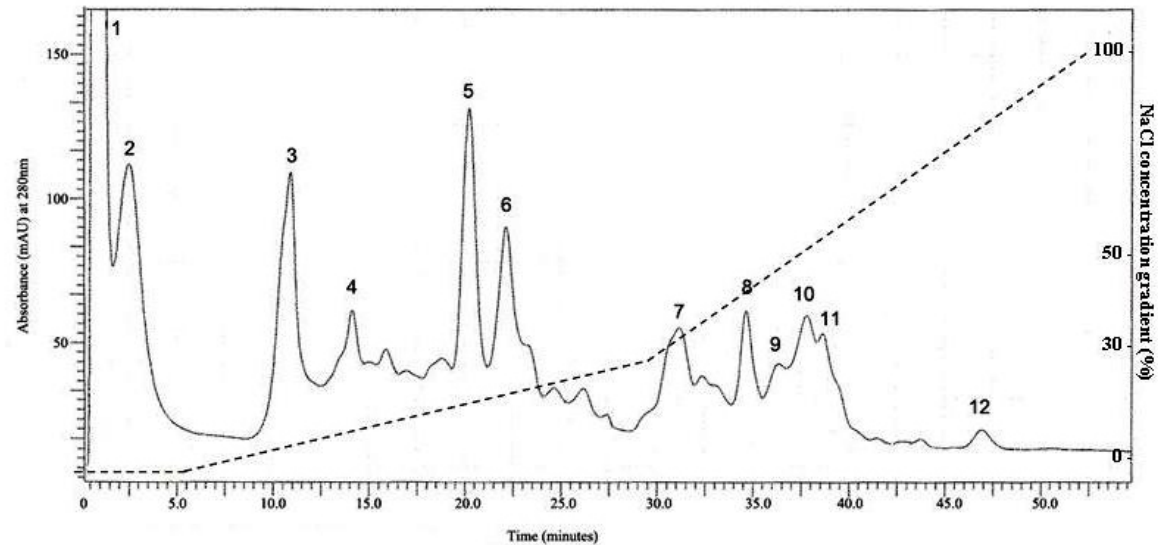
Figure 1. Fractionation of Hypnale hypnale venom with Resource® Q anion exchange chromatography. The venom (5 mg) was injected into the column equilibrated with 20 mM Tris-HCl, pH 8.5, and eluted by a linear, 0.0 to 0.5 M NaCl gradient (0-30% from 5 to 30 minutes, followed by 30-100% from 30 to 55 minutes. Flow rate was 1 mL/min. (-----): NaCl concentration gradient